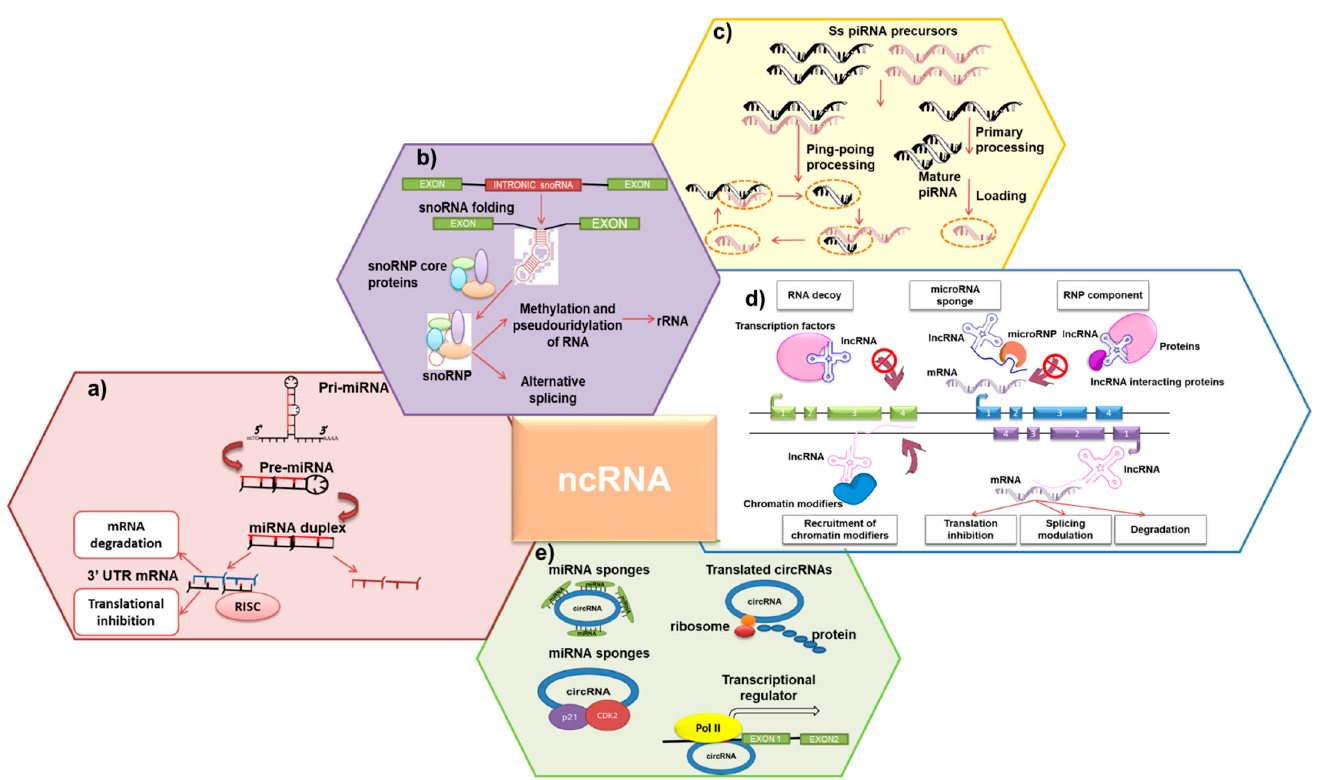
Figure 1. Molecular features and mechanism of action of the different ncRNA classes. ( a ) After being transcribed in the nucleus from a primary-miRNA (pri-miRNA), precursor miRNAs (pre-miRNAs) are exported by exportin 5 in the cytoplasm and processed by Dicer, which generates mature miRNAs, then loaded into the RNA-induced silencing complex (RISC). miRNAs function through degradation of protein-coding transcripts or translational repression. ( b ) Mature snoRNAs generated by splicing, debranching and trimming are either exported from the nucleus, where they regulate ribosomal RNA (rRNA) processing, or remain in the nucleus, where they can regulate alternative splicing. ( c ) piRNAs are expressed as single stranded RNAs (ss piRNAs) or produced through a secondary amplification loop. The PIWI ribonucleoprotein (piRNP) complex functions in transposon repression through target degradation and epigenetic silencing. ( d ) LncRNAs can modify gene expression by multiple mechanisms: they can act as decoy of transcription factors, sponge for miRNAs, regulators of splicing, recruiters of chromatin modifier complexes or modulate mRNA stability. ( e ) circRNAs can bind miRNAs acting as a sponge to regulate downstream transcription, or can enhance the expression of host genes by improving the activity of Pol II in the nucleus. Part of the circRNA can also encode peptides or proteins.